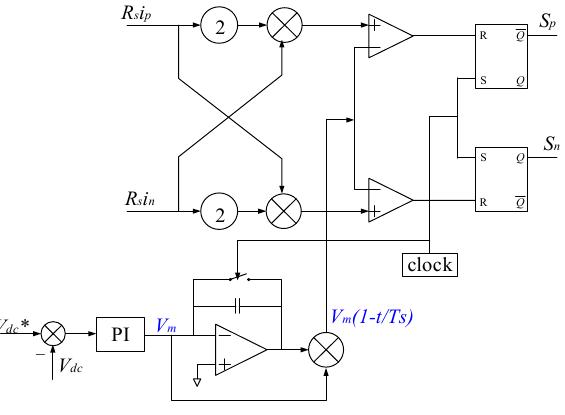
Figure 3. Core Circuit of one-cycle controller.